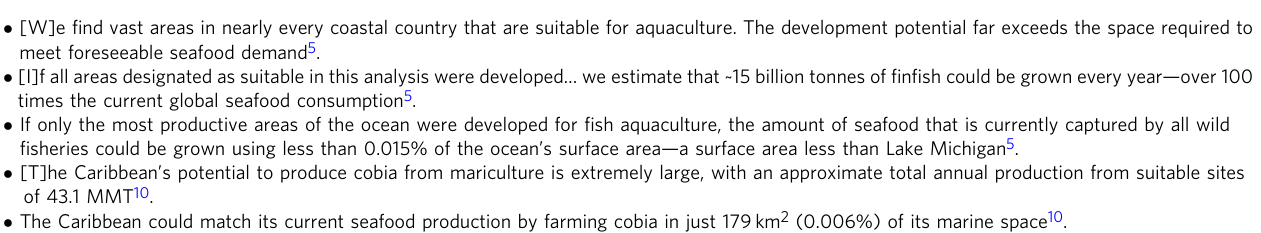
Table 4 Claims about potential for spatial expansion of marine